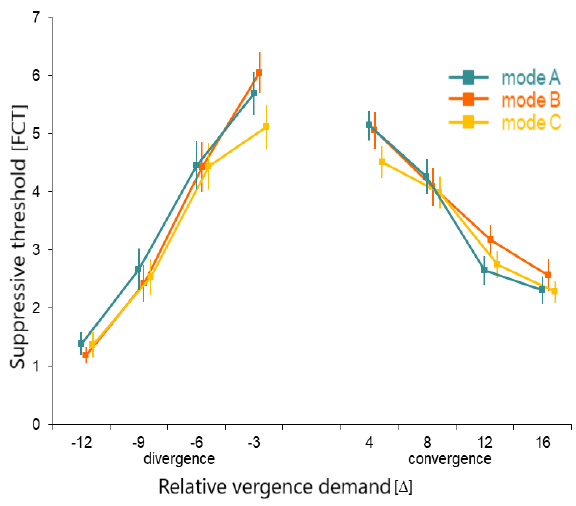
Figure 6. Mean suppressive thresholds in relation to relative vergence demand and degradation mode of non-dominant eye image. Verical bar = standard error of mean.